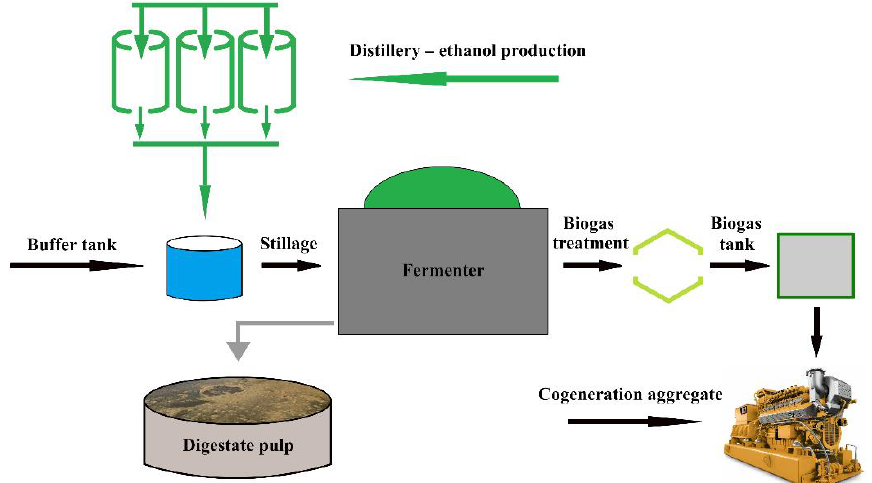
Figure 1. Conceptual scheme of integrated bioethanol and biogas production (authors’ own scheme).